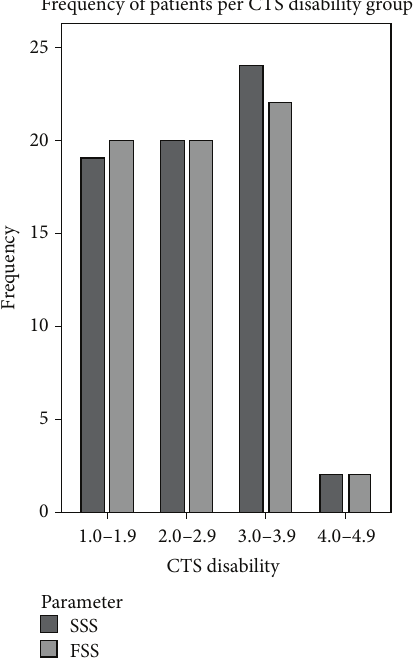
Figure 1: Frequency of patients versus increasing CTS disability (SSS and FSS) assessed using the Levine-Katz questionnaire.